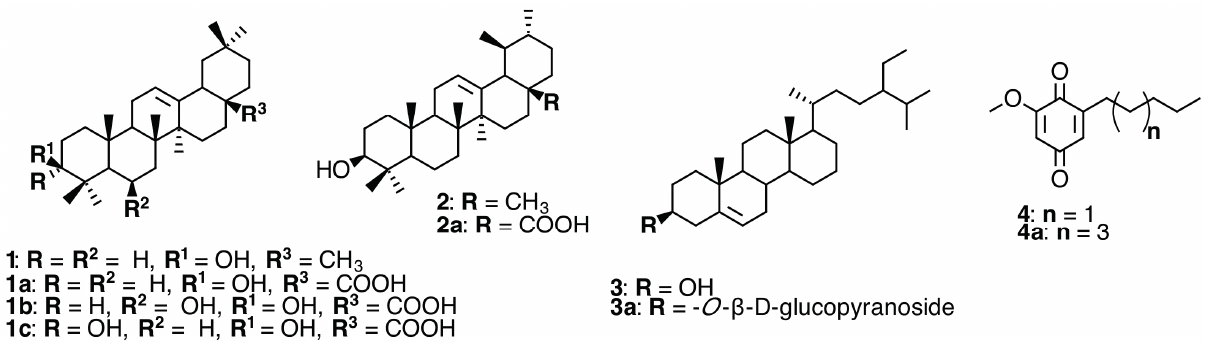
Figure 1. Triterpenoids, steroids, and alkyl benzoquinones.